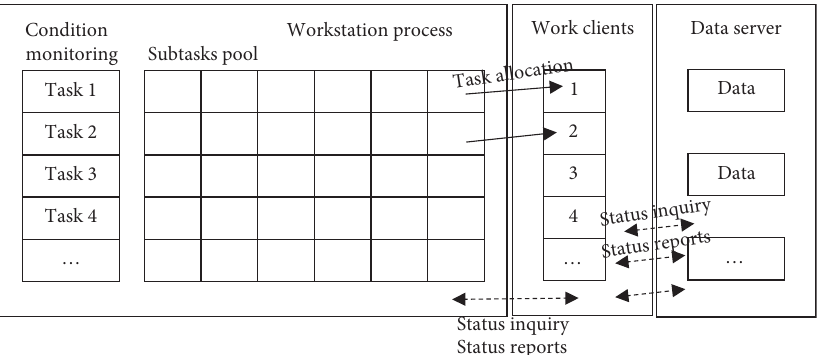
Figure 3: Distributed computing system architecture.